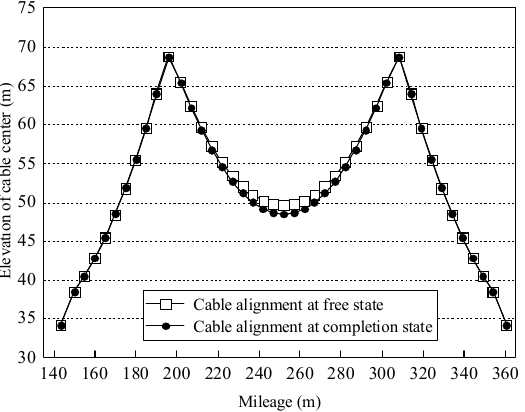
Figure 11. Results of cable alignments at erection and completion states of the Hunan Road Bridge.